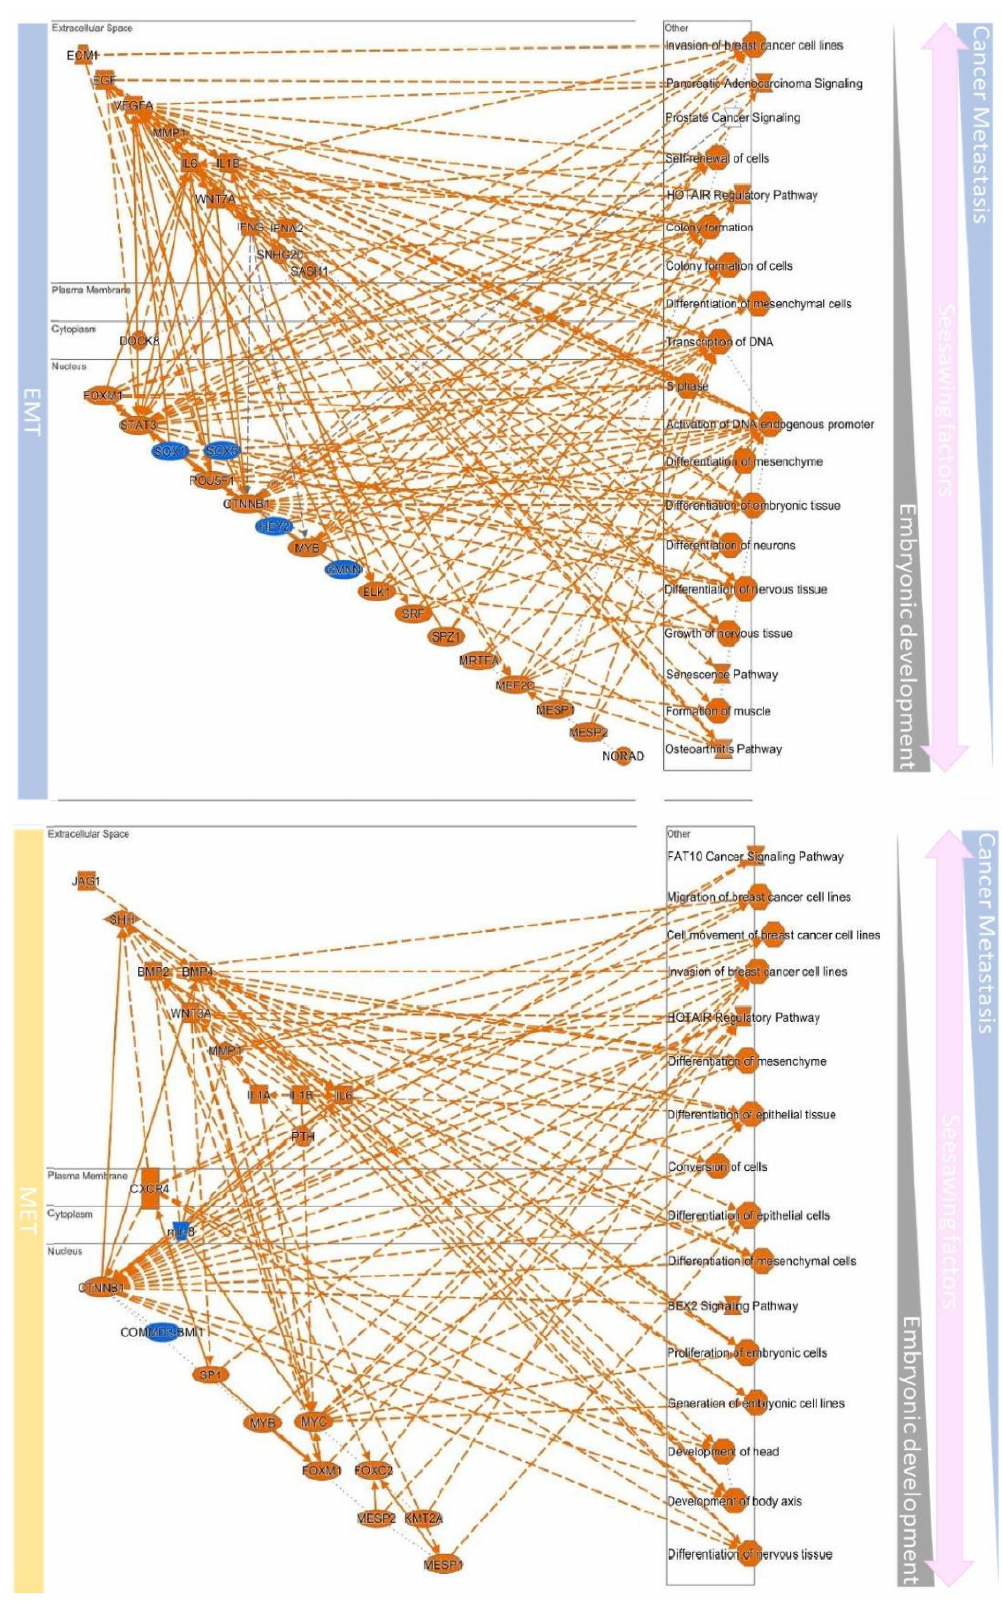
Figure 9. The upstream regulators of EMT/MET dominate both embryonic development and cancer progression. A simulation of molecular interactions of EMT and MET hallmarks upstream regulators and the related biological functions of participation was conducted through prediction